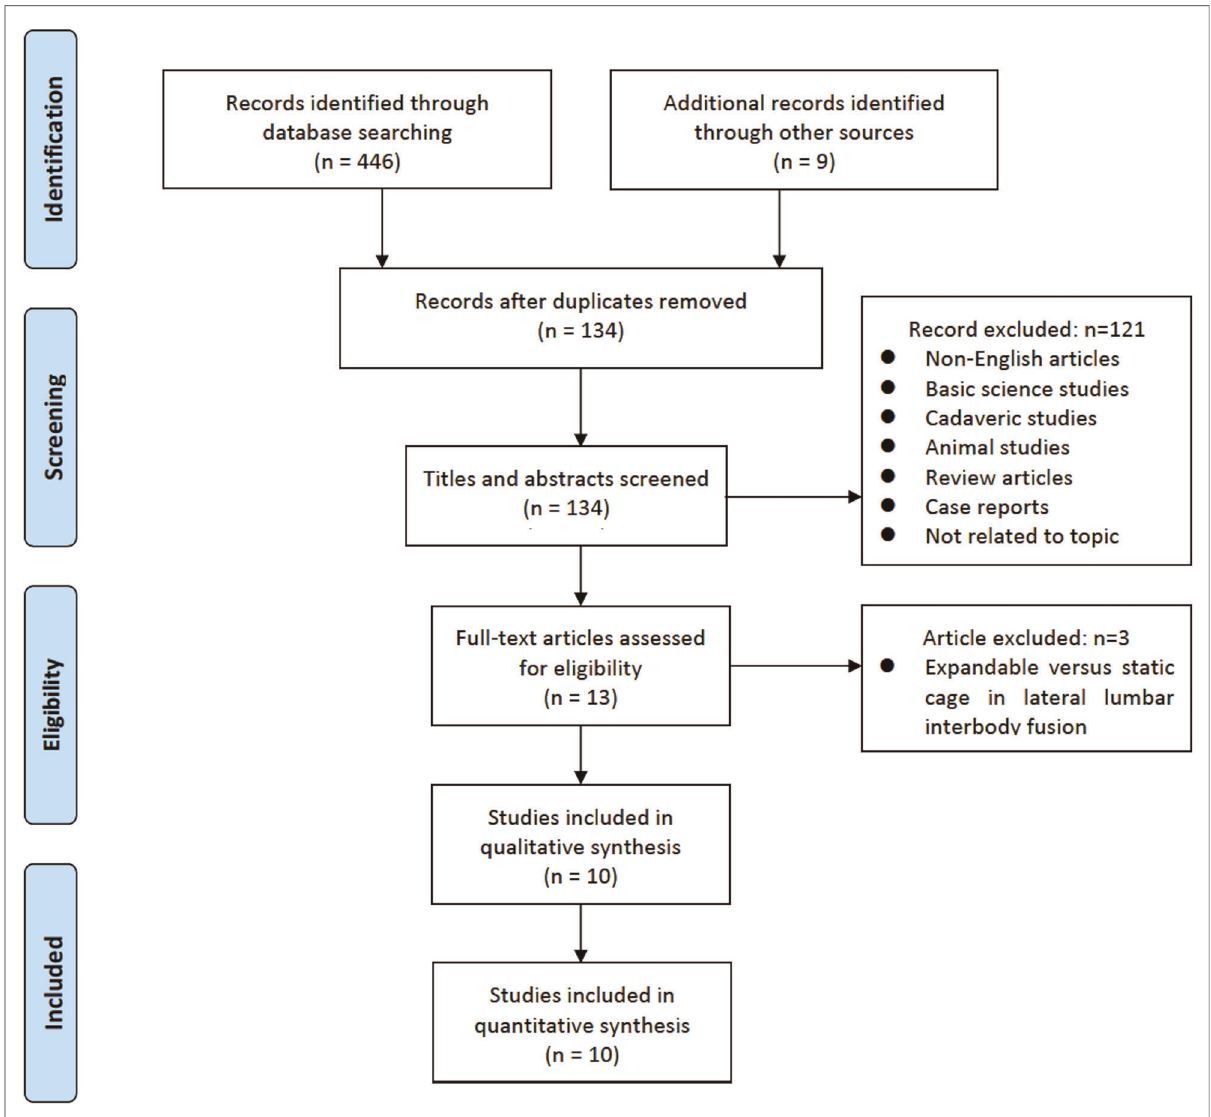
FIGURE 1 Study selection fl ow diagram for the